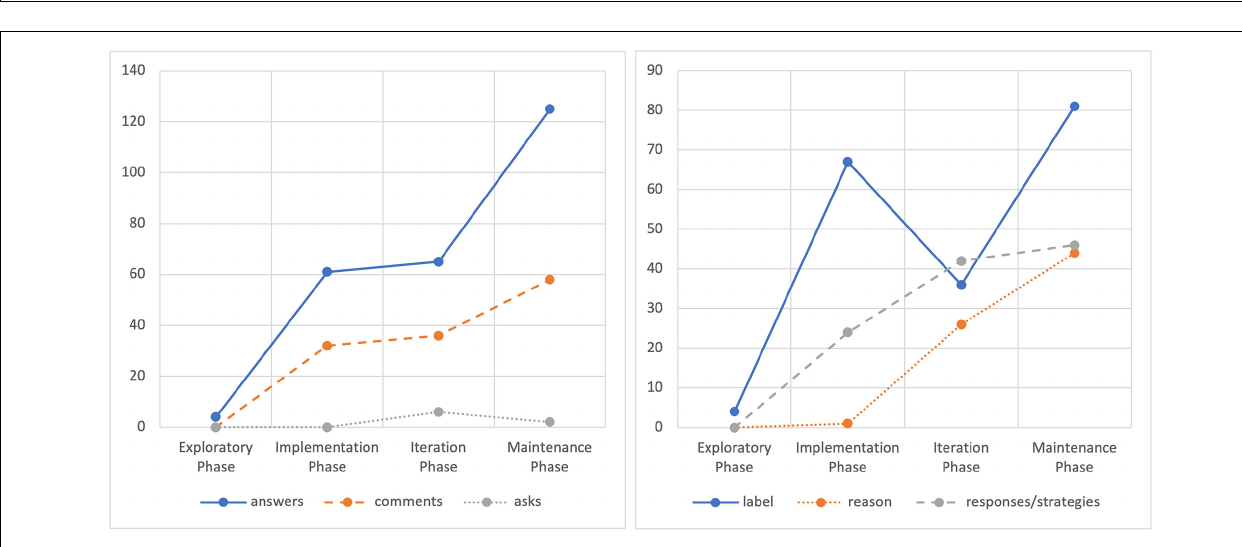
FIGURE 4 | Development of the child’s conversational utterances about emotions [answers, asks questions, comments] and type of emotional content discussed [label, reason, and responses to